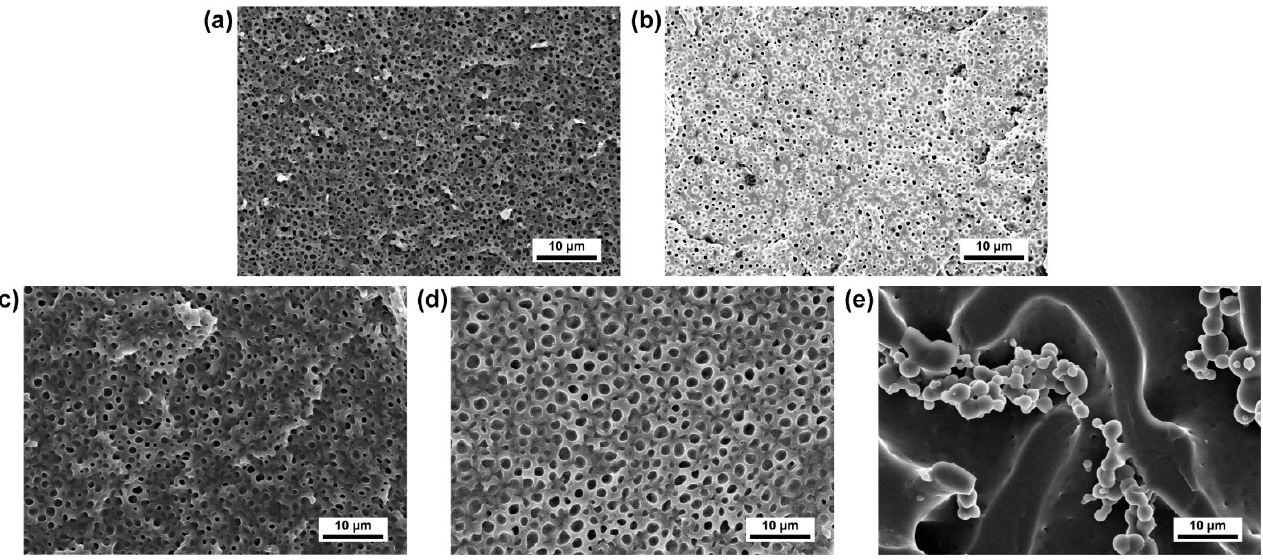
Figure 9. The polymer morphologies of samples D1–D5: ( a ) Sample D1; ( b ) Sample D2; ( c ) Sample D3; ( d ) Sample D4; ( e ) Sample D5.